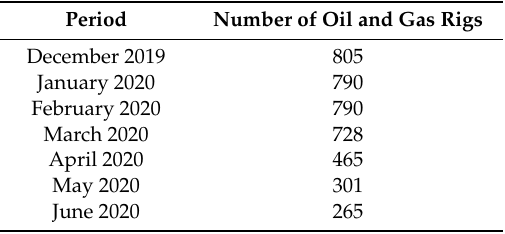
Table 2. Number of oil and gas rigs in operation in the US between December 2019 and June 2020.